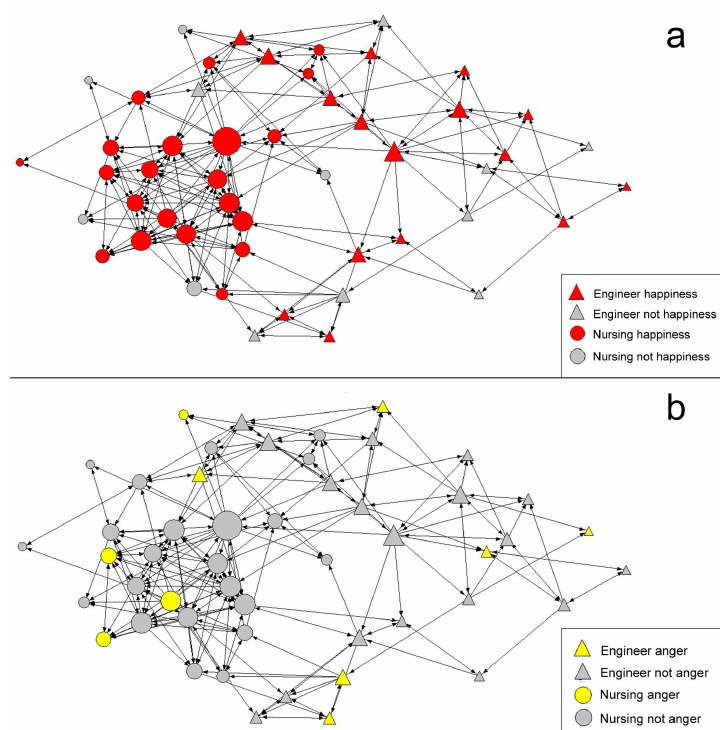
Figure 5. Graph of the post-intervention friendship network with Happiness emotion ( a ) and with Anger emotion ( b